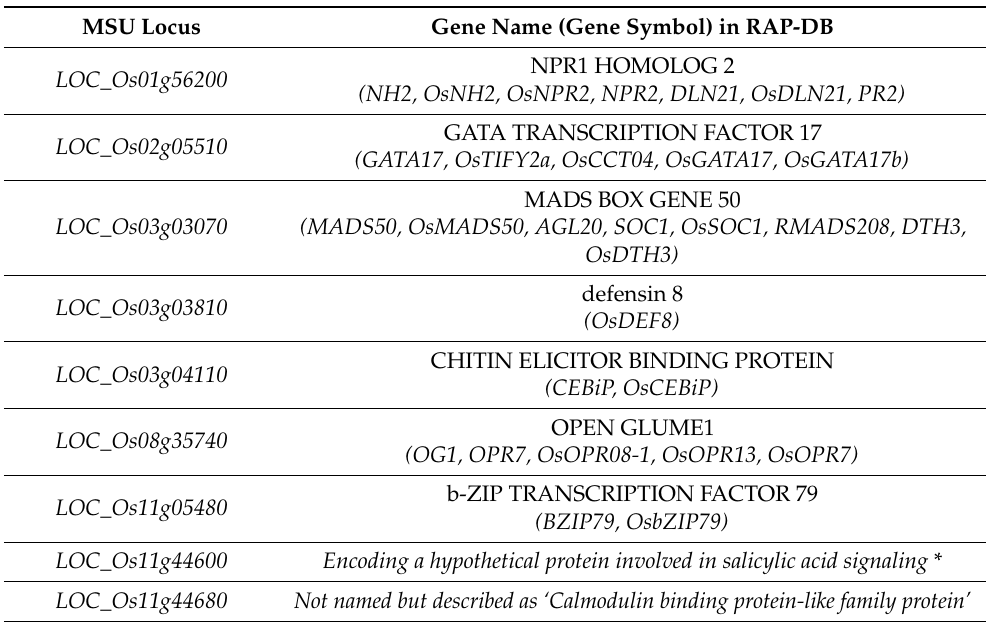
Table 7. Candidate genes related to plant defense, signaling, and flowering revealed by QTL- seq analysis.